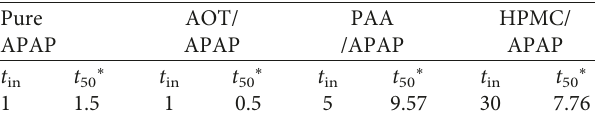
Table 1: Summary of crystallization parameters of each system on CS films.